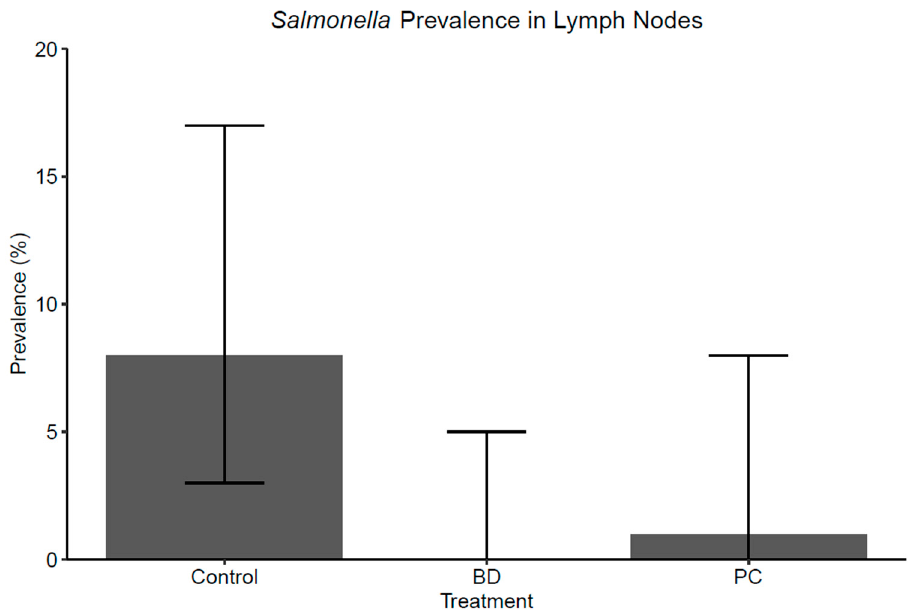
Figure 6. Salmonella prevalence (%) in bovine, subiliac, peripheral lymph node samples collected from the carcasses of the same cattle that were studied in the fecal portion of this study. The total number of positives for each treatment group, from all PLNs collected was Control: 6/74, BD: 0/72 and PC: 1/69. Error bars represent 95% confidence intervals (CI).